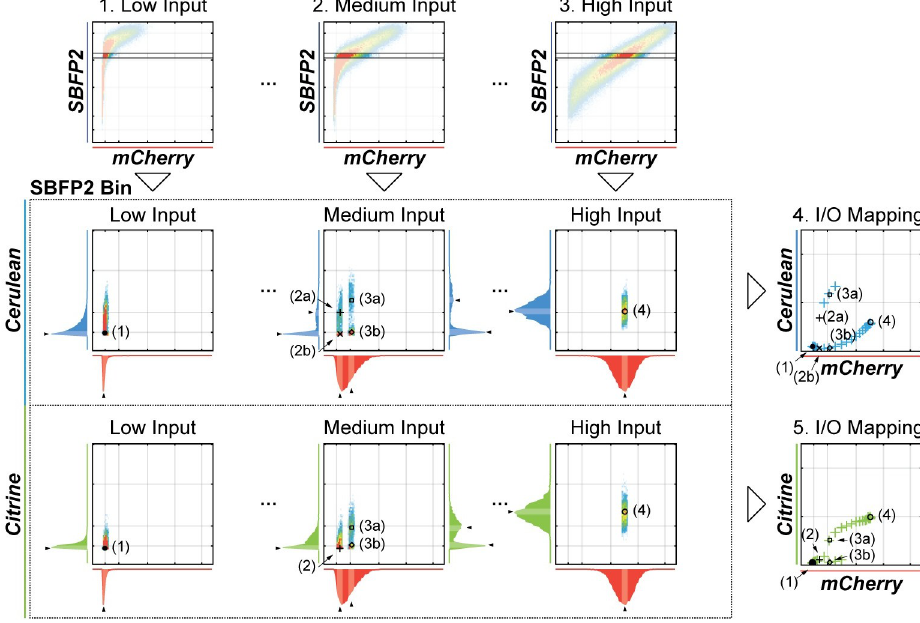
Fig 4. Peak Finder Algorithm For Flow cytometry (PFAFF) analysis strategy. The steps of finding peaks in distributions of a binned data as shown in Fig 2C are repeated for every input induction level (i.e. Doxycycline level; here three representative cases for low ( 1 ), medium ( 2 ) and high ( 3 ) input modulation levels are depicted) for each output (here, Cerulean and Citrine). Initially, a bin of the transfection reference protein (here, SBFP2) is determined and all downstream analyses only deals with cells residing in this bin. The plots in the dashed box show the example workflow of applying the peak finding to the individual input modulation levels. The density plots depict the binned data and the adjacent histograms show the distributions of their respective input and output proteins. Black wedges indicate the modes of the (convoluted) distributions and black markers indicate their location on the density plots. The [ input ; output ] mode pairs, identified in this workflow (markers), derived from the raw data corresponding to the different input modulation level are plotted on the input/output mapping charts the output Cerulean ( 4 ) and Citrine ( 5